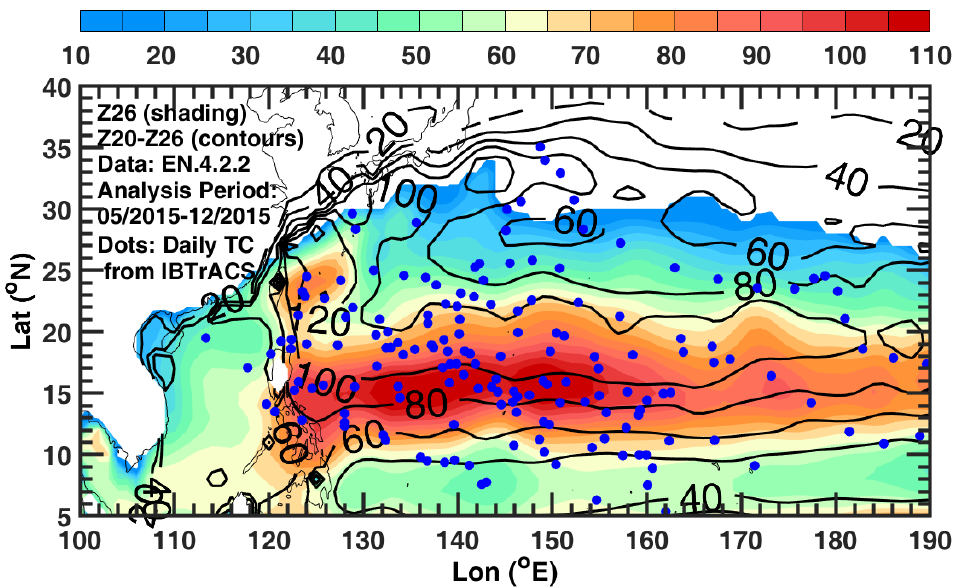
Figure 1. Daily, 12 UTC TC locations (blue dots) for May–December, 2015, from the IBTrACS data [19] (https://www.ncdc.noaa.gov/ibtracs/ accessed on 16 August 2022) superimposed on the same period’s weighted mean h 1 (=Z 26 ) and h 2 (=Z20 − Z26) (m) from the EN4 reanalysis [20] (https: //www.metoffice.gov.uk/hadobs/en4/download-en4-2-2.html accessed on 23 September